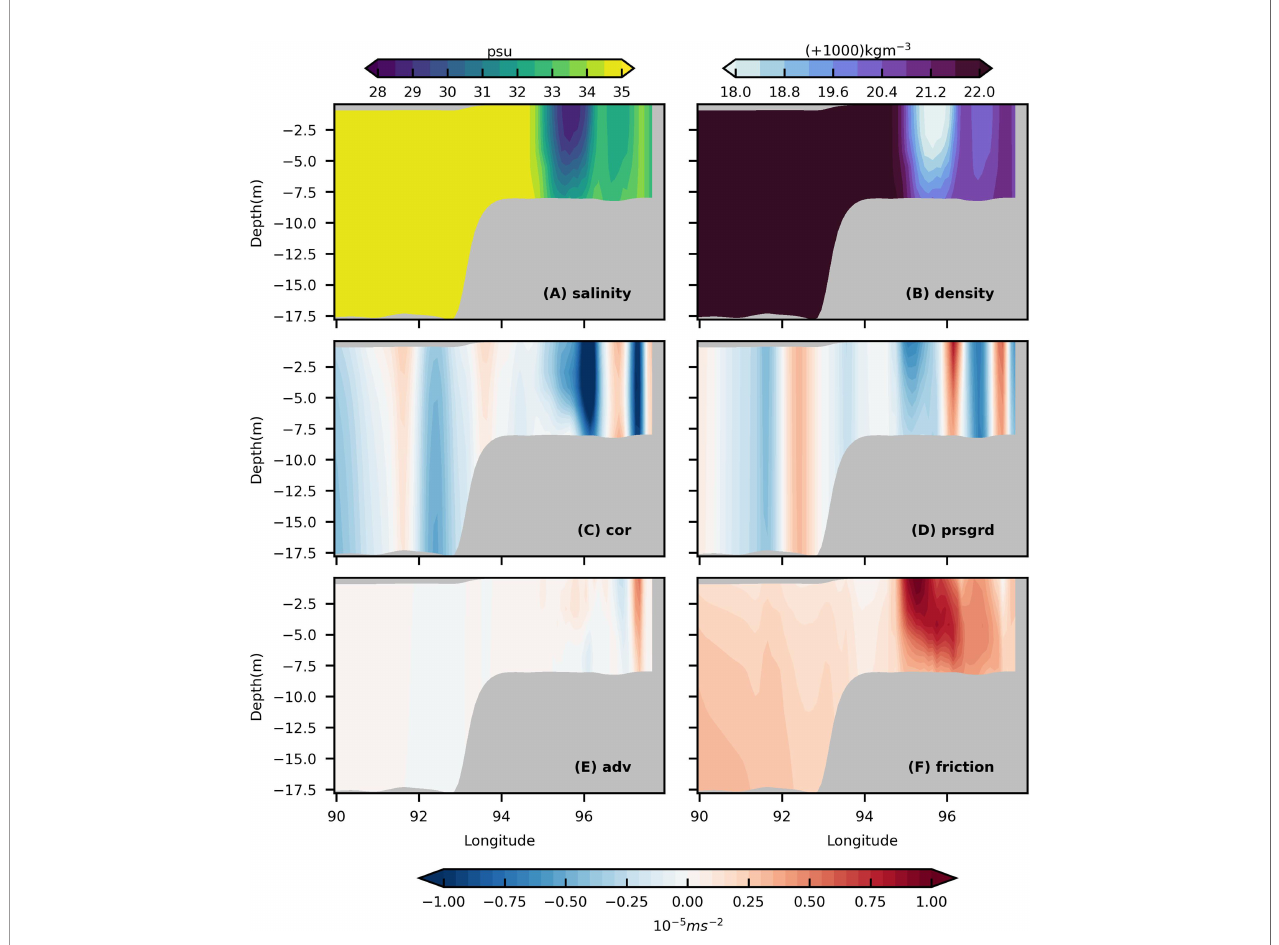
FIGURE 12 | Distribution of (A) salinity, (B) density and (C – F) u-momentum terms from the sixth year of experiment IRFullW for month of August. The distribution presented is across